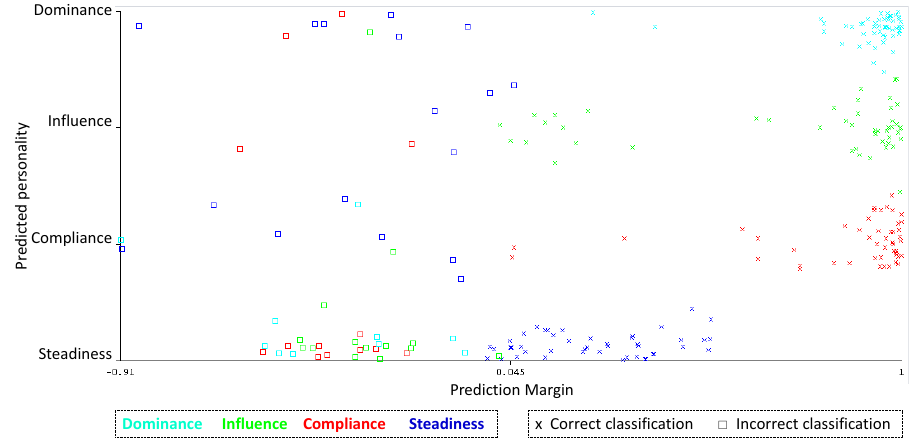
Figure 4. Actual personality versus predicted personality comparation.